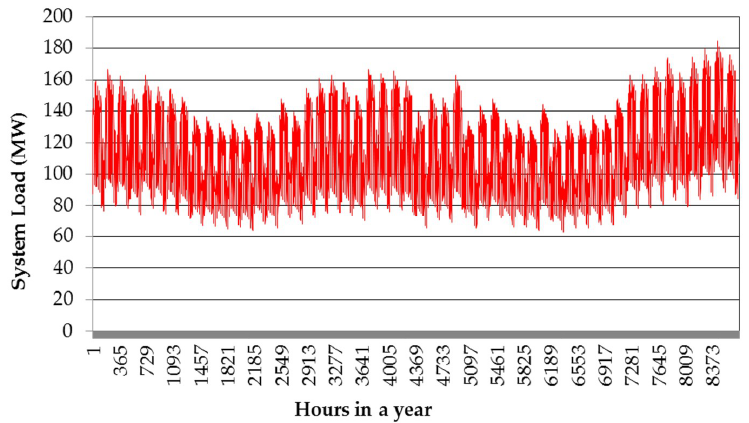
Figure 1. Single line diagrams of the Roy Billinton Test System (RBTS).